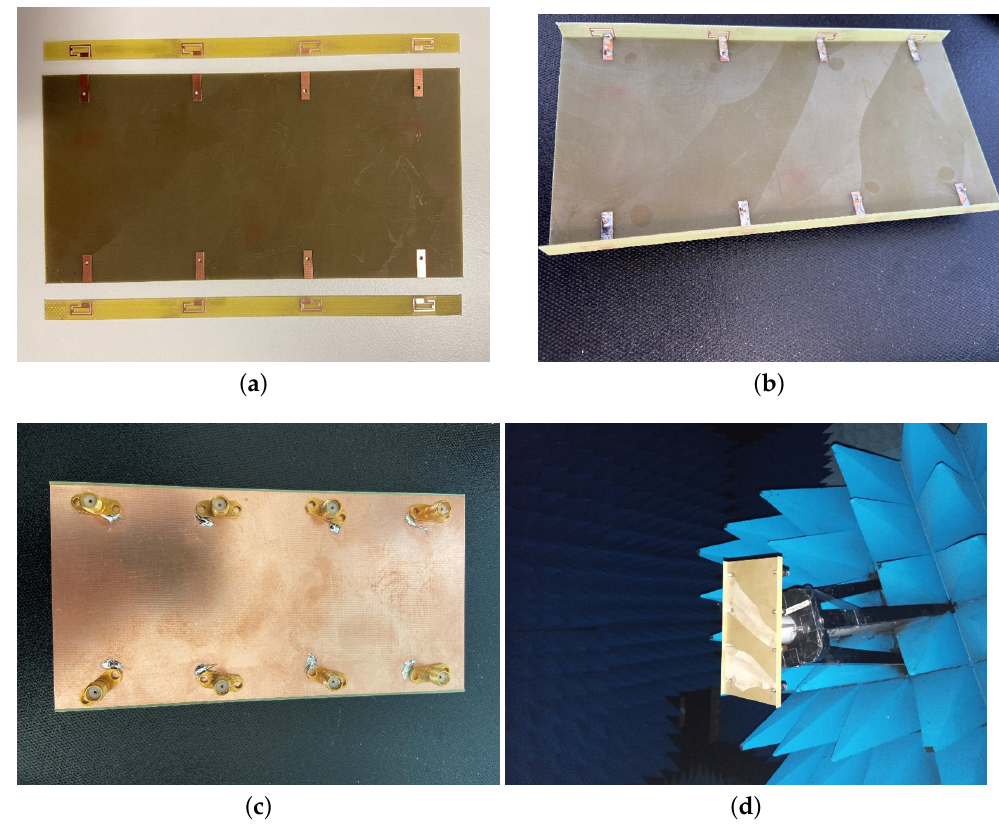
Figure 7. Fabricated prototype ( a ) before assembly; ( b ) front side; ( c ) back side; ( d ) radiation pattern measurement setup.